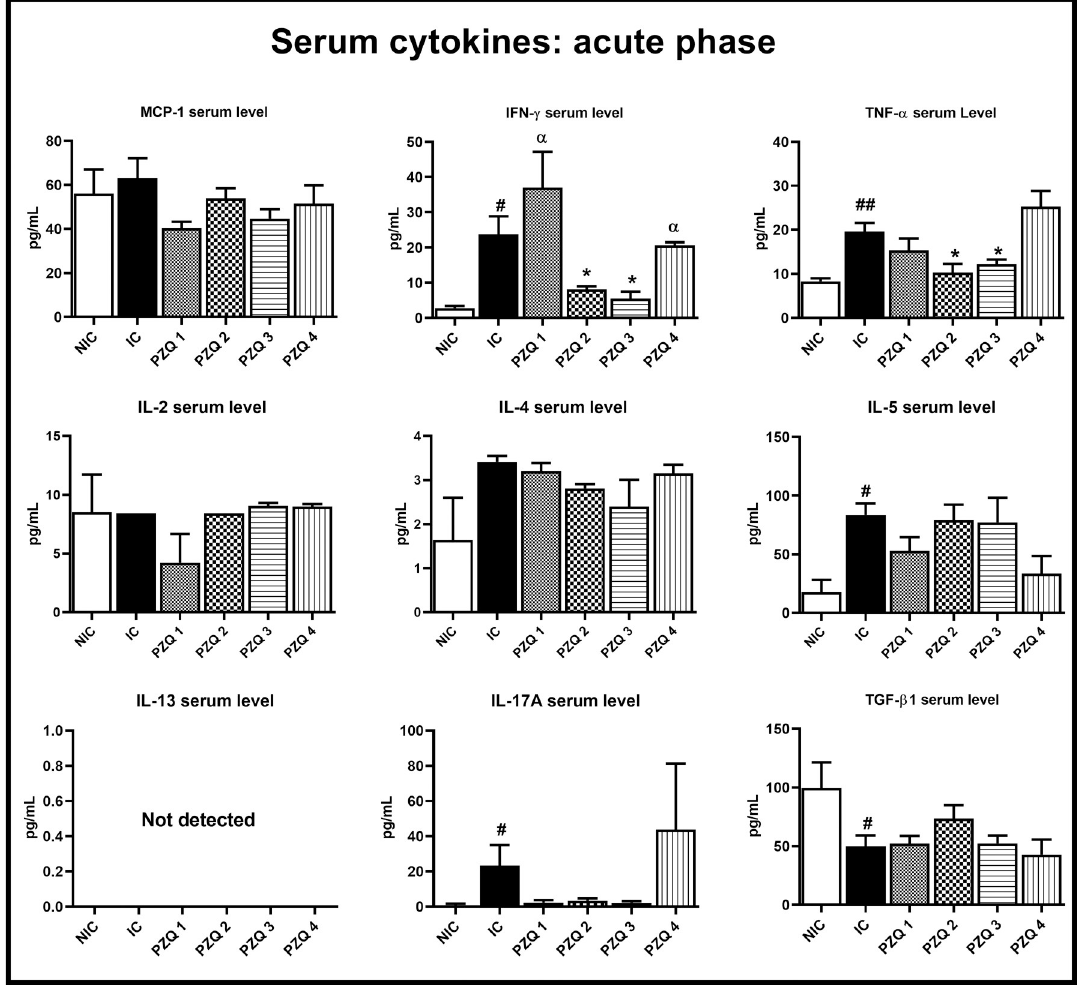
Fig 10. Effect of praziquantel treatment on the serum cytokine levels during the acute stage of Schistosoma mansoni infection in mice. HC: Uninfected mice, IC: Infected-untreated mice, PZQ1: Infected mice treated with praziquantel at 100 mg/kg for 5 consecutive days, PZQ2: Infected mice treated with praziquantel at 100 mg/kg for 28 consecutive days, PZQ3: Infected mice treated with praziquantel at 18 mg/kg for 28 consecutive days, PZQ4: Infected mice treated with a single dose of praziquantel at 500 mg/kg. Data are expressed as mean ± SEM (n = 6). ANOVA followed by Tukey multiple comparison test was also used for statistical analysis. # p < 0.05, ## p < 0.01: values are significantly different from those uninfected mice (group HC). � p < 0.05: values are significantly different from those of infected-untreated mice (group IC). α p < 0.05: values are significantly different from those of infected mice treated with PZQ3 posology (group